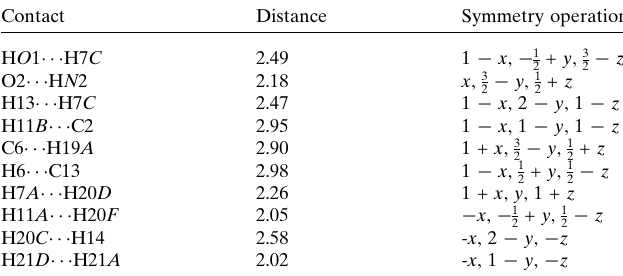
Table 2 Summary of short interatomic contacts (A˚ ) in the title compound. Contact Distance Symmetry operation